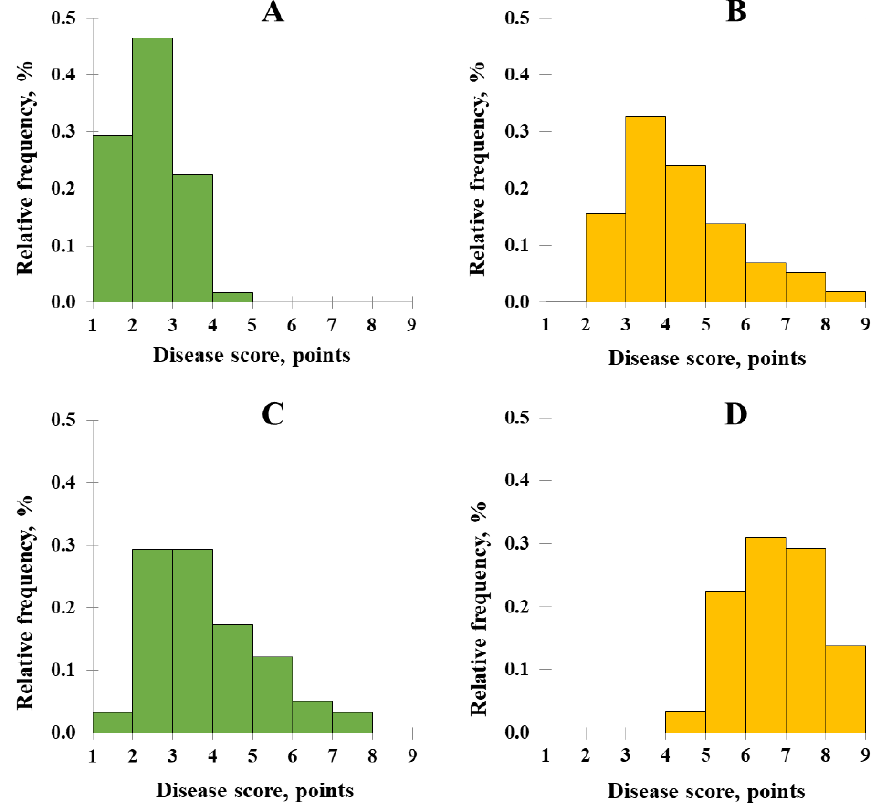
Figure 2. Histograms of the distribution of winter rye samples by the degree of snow mold damage under a natural infection background (NIB, green columns) ( A , C ) and an artificially-enriched infection background (AIB, yellow columns) ( B , D ) in 2020 ( A , B ) and 2021 ( C , D ).